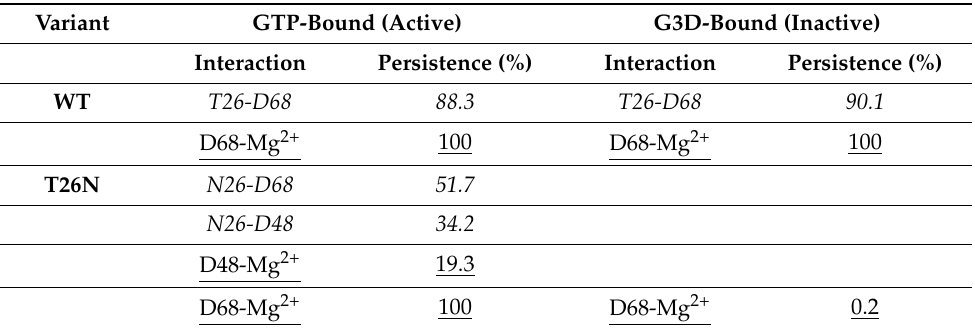
Table 3. Persistence over 500 ns molecular dynamics (MD) simulations of the interactions involving T/N26 and Mg 2+ -binding. H-bonds and electrostatic interactions are shown in italics and underlined, respectively. Variant GTP-Bound (Active) G3D-Bound (Inactive) Interaction Persistence (%)